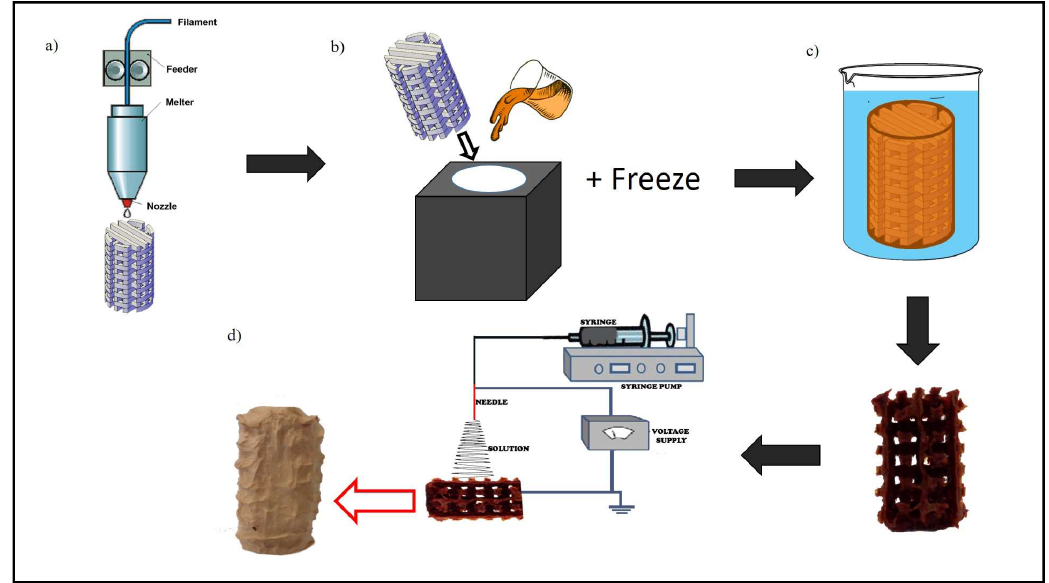
Figure 1. Schematic diagram of the processing technique involved in 3D scaffold fabrication: ( a ) constructing three dimensional (3D) template from partially hydrolysed polyvinyl alcohol (PVA) filament by using 3D printer; ( b ) inserting PVA 3D template into mould and pouring PVA/maghemite solution and freezing it; ( c ) after PVA/maghemite completely solidifies, removing the PVA 3D template by immersing in water; and ( d ) electrospinning PVA/maghemite solution on the 3D PVA/maghemite construct.